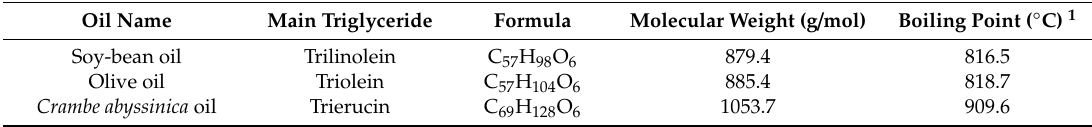
Table 4. Oils properties